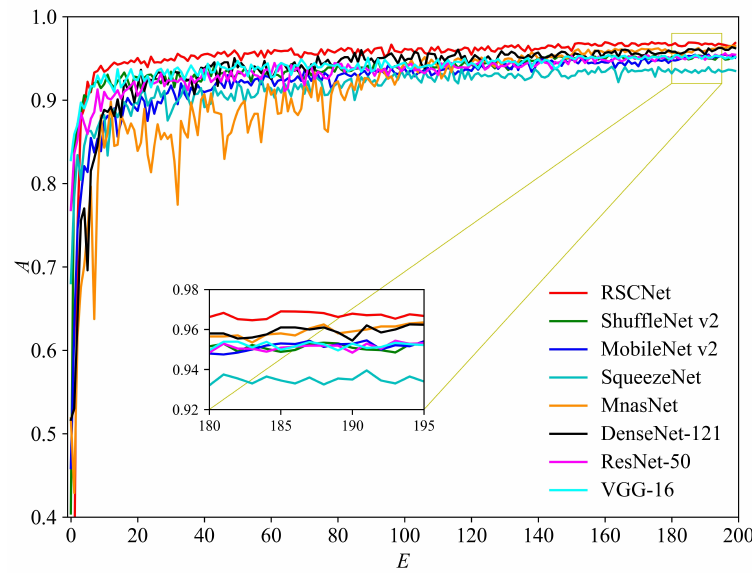
Figure 10. Performance comparison of various models on AID.